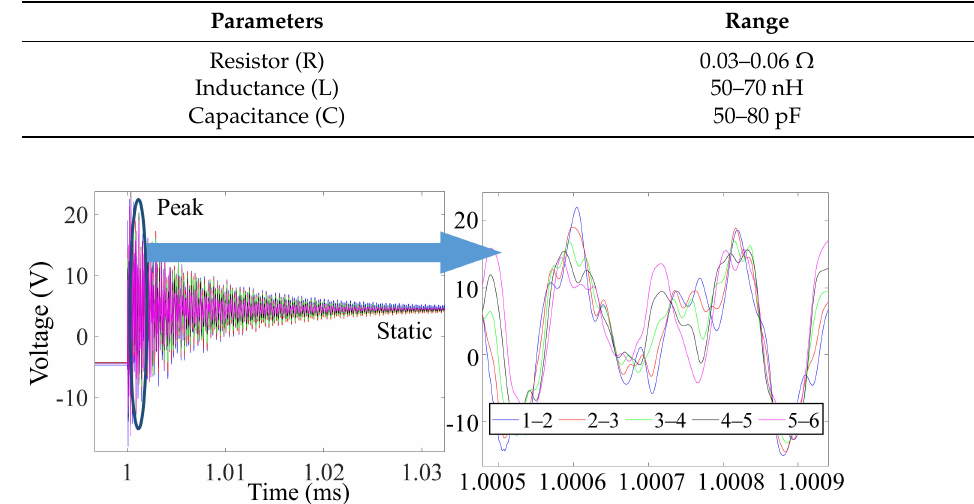
Figure 5. Equivalent circuit model of the transformer’s HV winding (values of Lx, Rx, and CX–Y lies in the range of R, L, and C listed in Table 3). Table 3. Value ranges of the stray parameters of the selected transformer prototype.